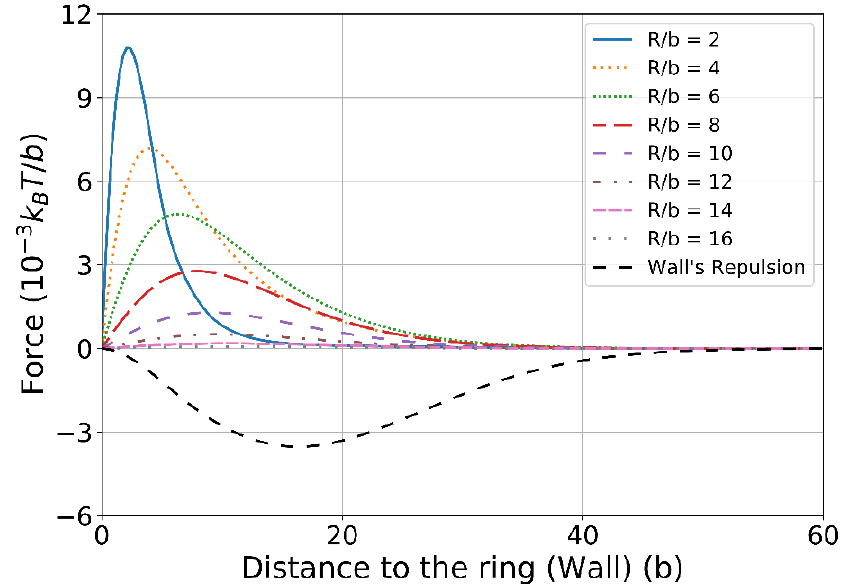
Figure 4. The entropic force felt by the chain when dragging one end of the chain away from the ring (solid lines) or the wall (dash line). Here, we set the force pointing in direction towards the ring or the wall as positive. In the legend, R denotes the ring‘s overall radius.